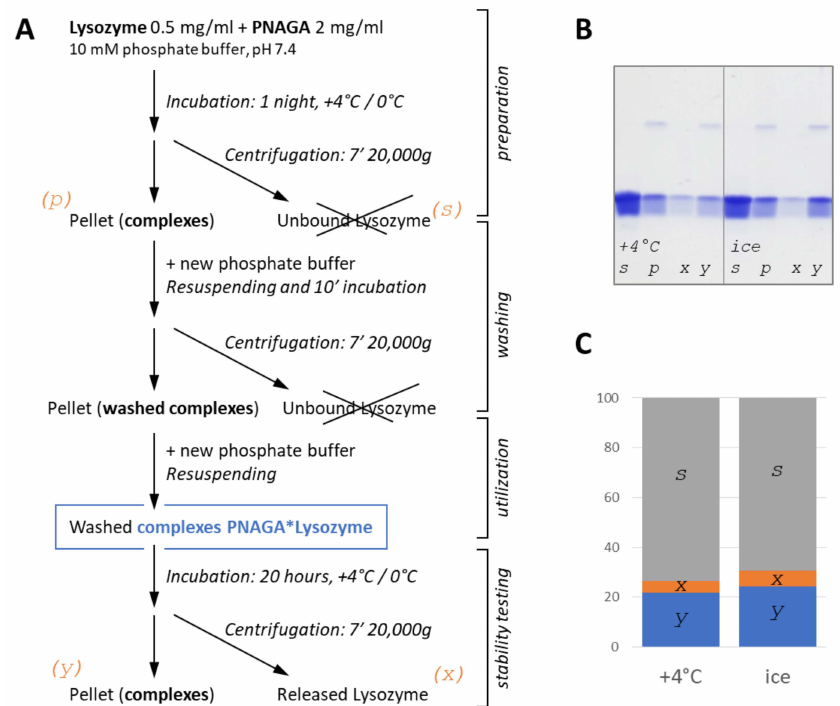
Figure 1. ( A ) The scheme of a simple procedure of mixing and cooling down followed by washing used to prepare stable PNAGA*Lysozyme complexes, as well as an additional step to test the complex stability. ( B ) SDS-PAGE of supernatant (s) and pellet (p) of the first centrifugation step, and supernatant (x) and pellet (y) of the last centrifugation after a stability test for complexes of PNAGA with Lysozyme obtained at +4 and at 0 ◦ C (on ice). ( C ) Amount of lysozyme in the above samples determined using Bradford protein assay and expressed as a percentage of total amount of